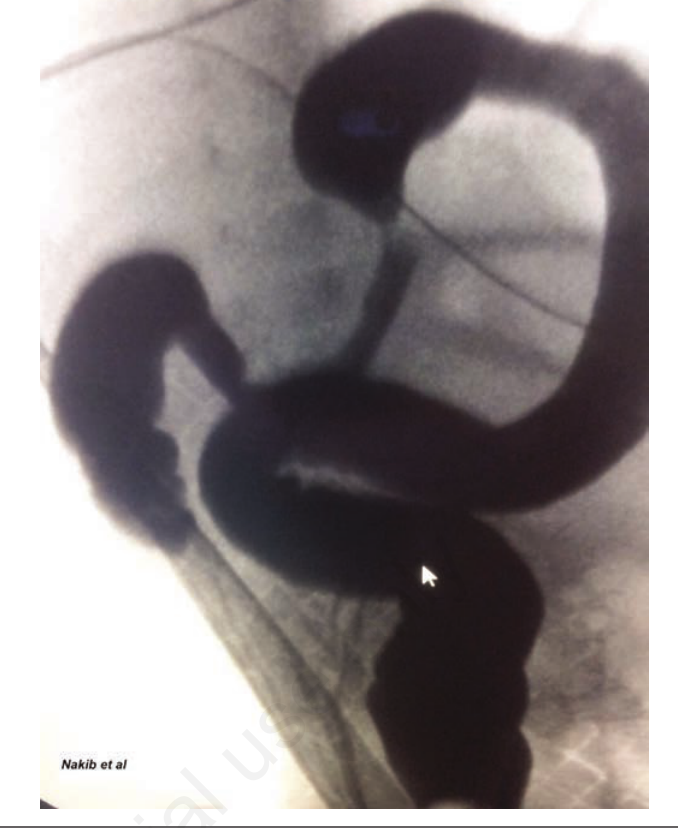
Figure 1. Contrast enema: stenosis of transverse colon.